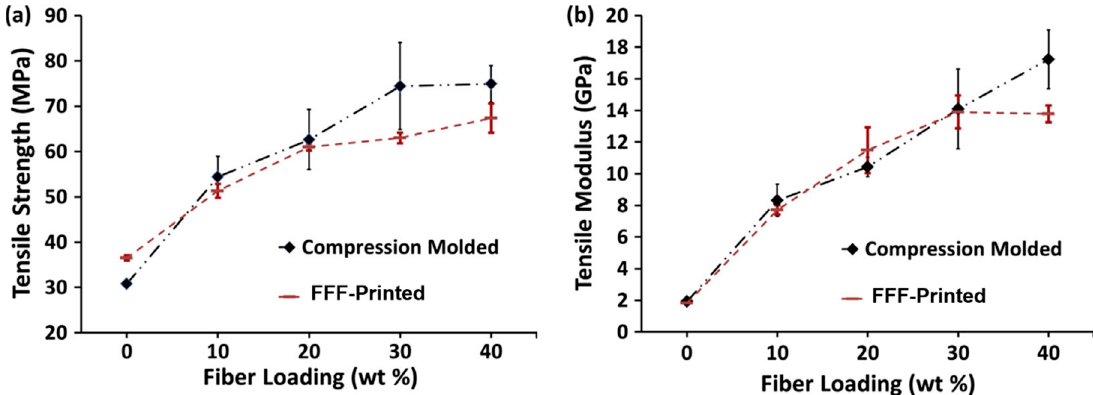
Figure 2. Effect of fibre content and preparation process on ( a ) tensile strength and ( b ) modulus of ABS/carbon fibre composites [34] .